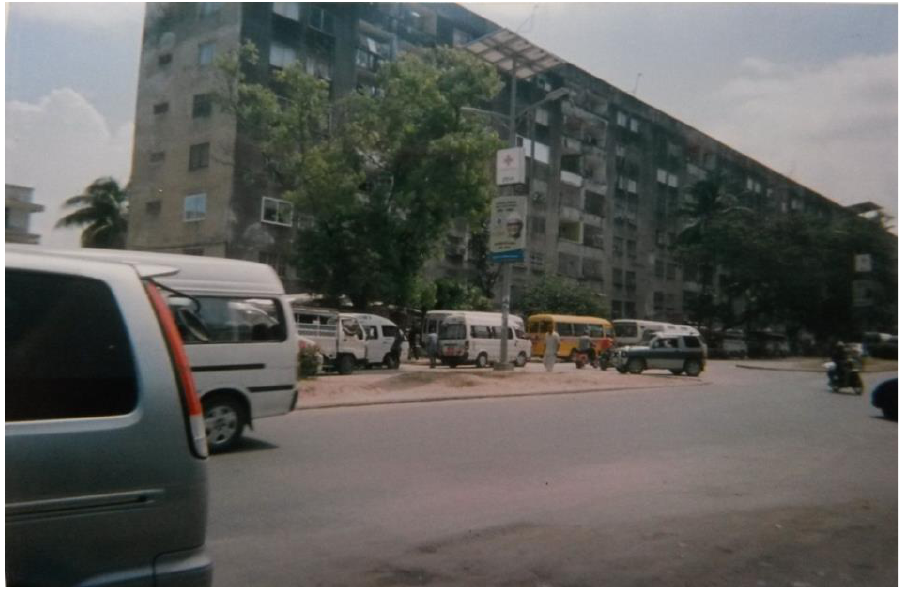
Figure 9. ‘An adult [ mtu mkubwa ] should help a child [ mtoto ] when they cross a street so that they will not have an accident especially when there are cars ’ . (Lubna, 13 years